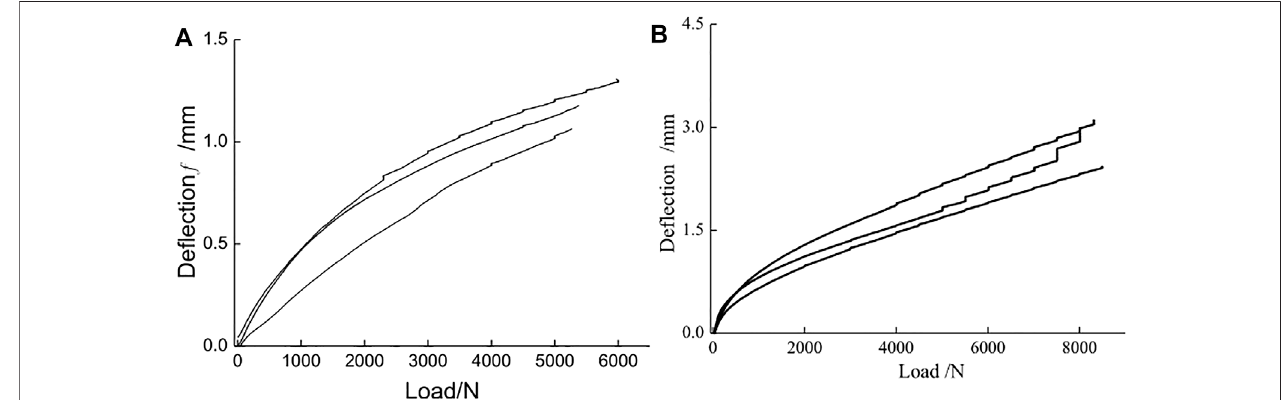
FIGURE 6 | Bending strength of specimens. (A) with cavity; (B) without cavity.